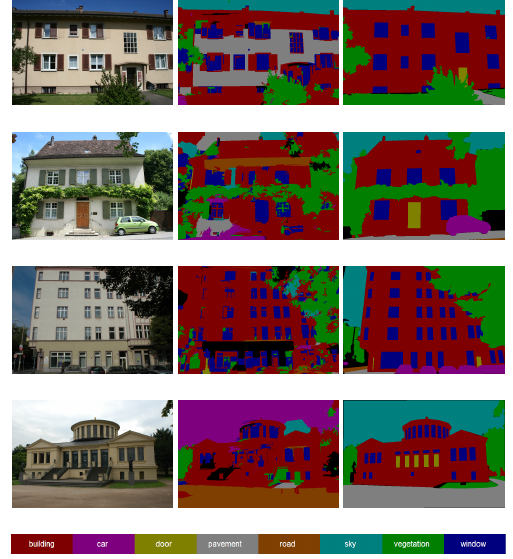
Figure 6: Some more classification results of a RDF classifier with the mean shift on the testing images from the eTRIMS dataset. ( Left : test image, middle : result, right : ground truth.)